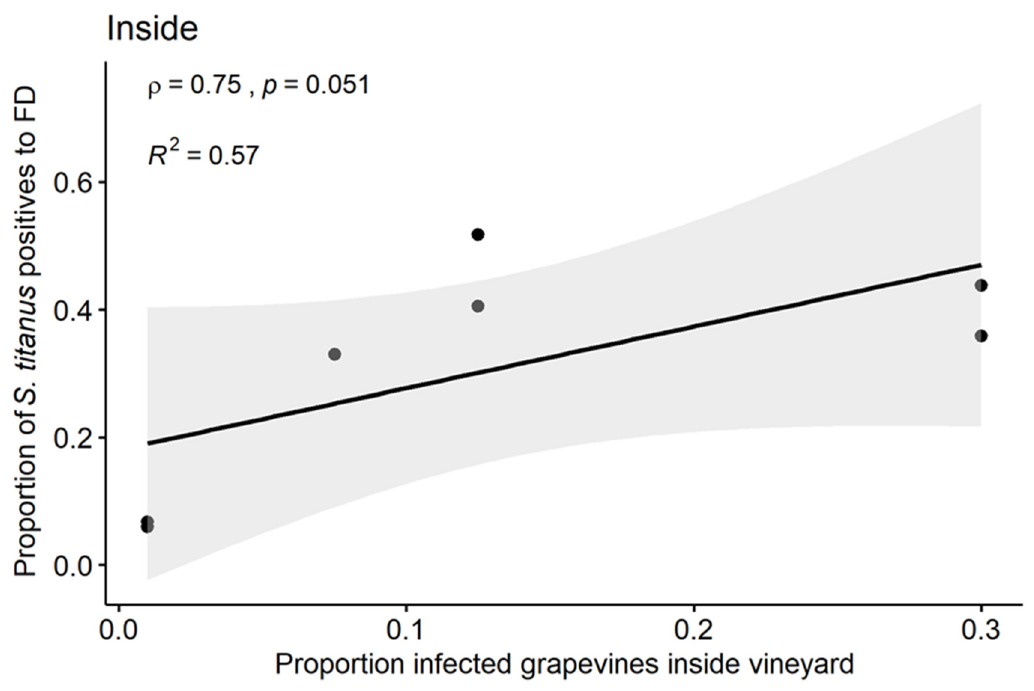
Figure 7. Correlation between proportion of FDp-positive S. titanus (collected inside the vineyard) and proportion of infected grapevines in the same vineyard. proportion of infected grapevines in the same